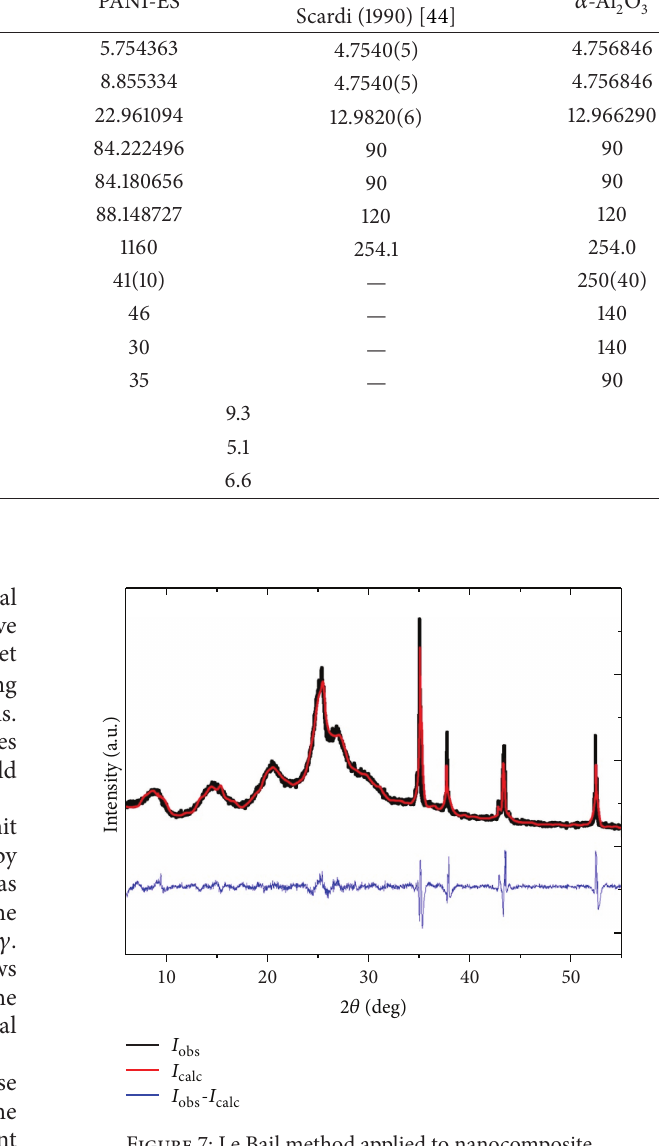
Figure 7: Le Bail method applied to